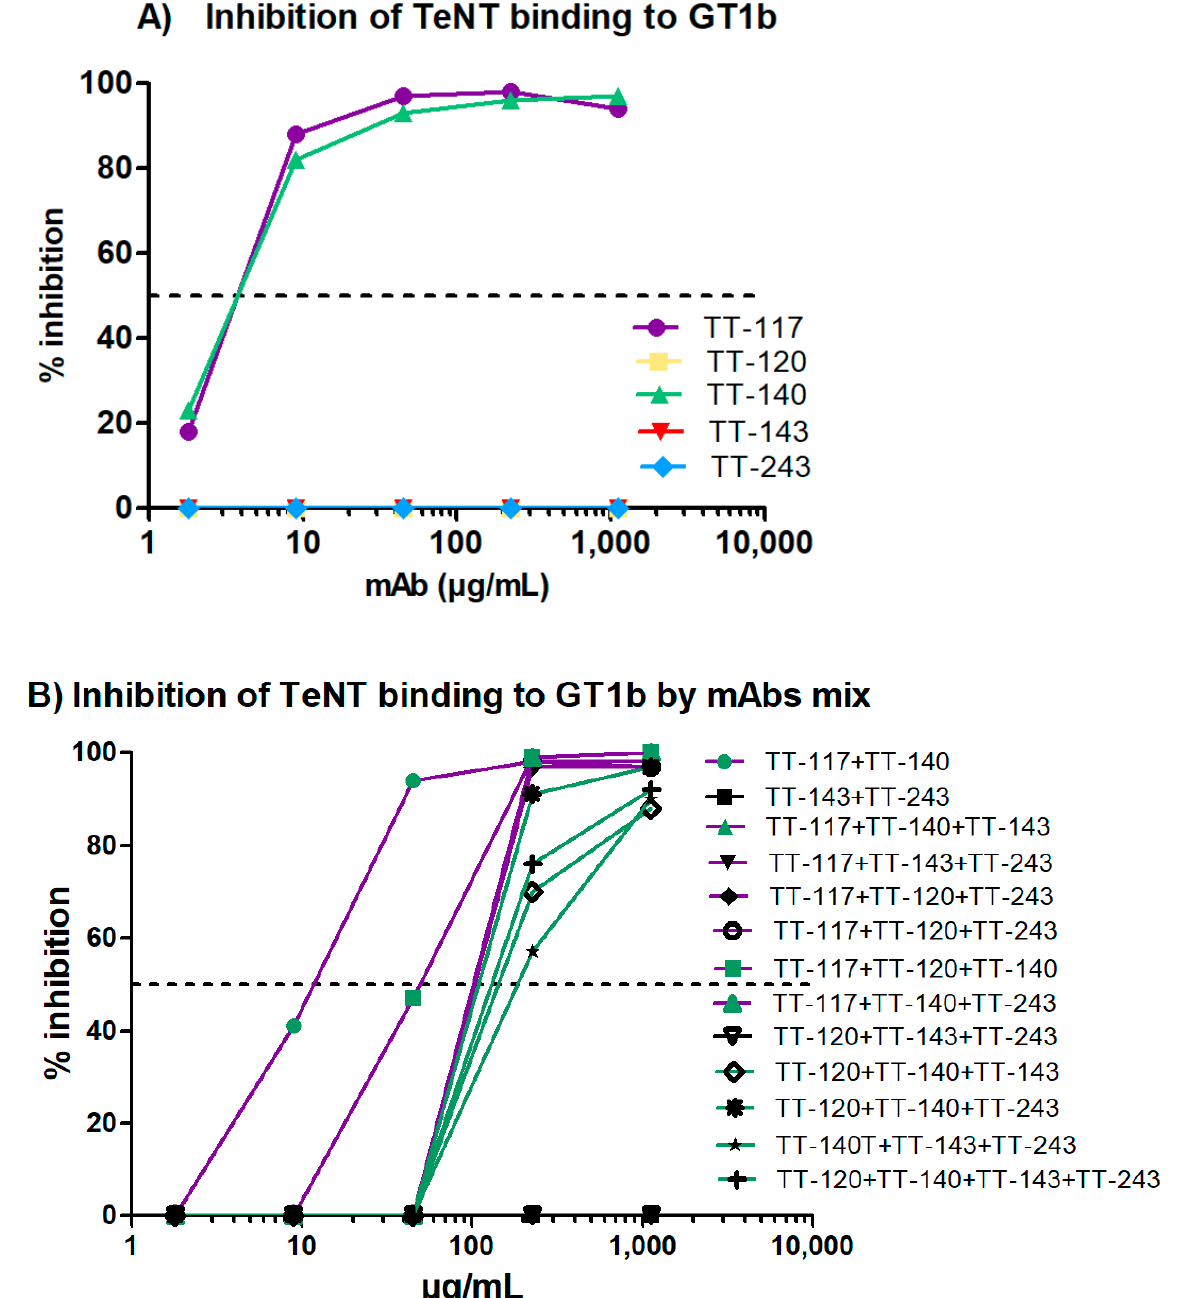
Figure 5. ELISA of the inhibition of binding of TeNT to ganglioside GT1b. The mAbs’ capacity to inhibit TeNT binding was assessed by incubating GT1b with an appropriate level of TeNT alone and increasing the mAb concentration from 0.4 to 50 ng/mL. ( A ) Five mAbs evaluated individually. ( B ) mAbs evaluated in mixtures; the total antibody concentration was always the same. The purple lines represent mixtures containing mAb TT-117; when TT-140 was also present, the symbols are green. The green lines represent mixtures containing only mAb